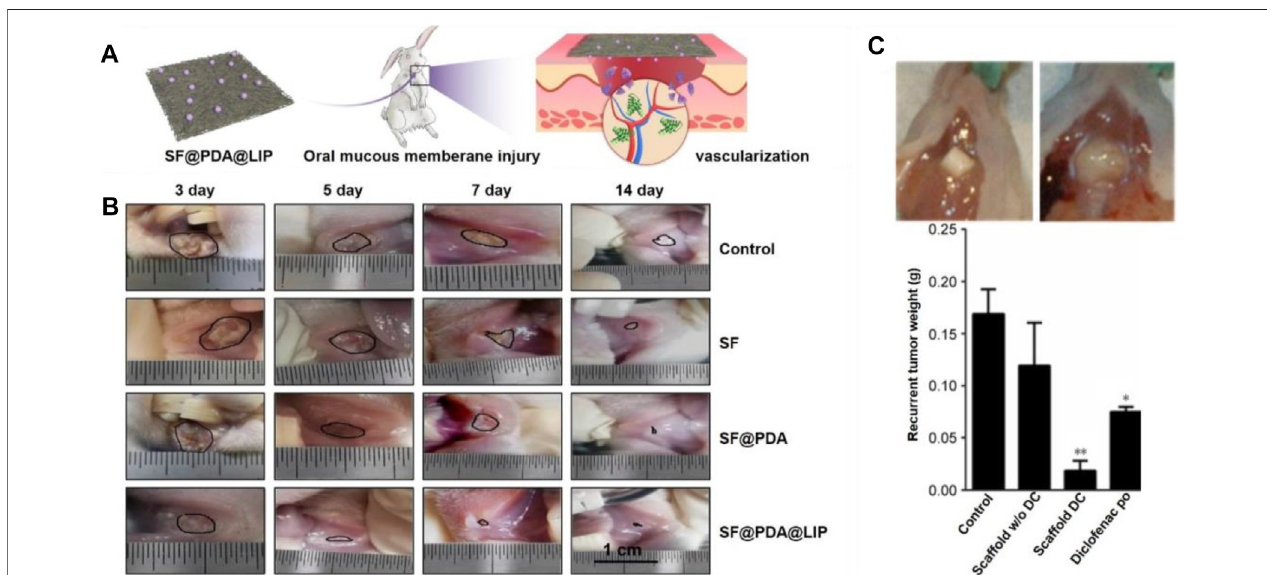
FIGURE9|(A) Silk fi broin fi bersdepositedwithleptin-loadedNH 2 -LIPswereusedtocoveroralmucousmembraneinjurytopromoteangiogenesis.Reproducedwithpermission (Qianetal.,2020).Copyright2020,CreativeCommonsAttribution. (B) Photographsshowingthehealingofinjuriesasmarkedbyblacklines.Reproducedwithpermission(Qianetal., 2020).Copyright2020,CreativeCommonsAttribution. (C) Effectofthelocalreleaseofdiclofenaconrecurrenttumorweight.Representativephotographsshowingtherecurrenttumor weightwaslowerwhentreatedbythediclofenac-loadedscaffoldat7 weekspostsurgery (topleft) .Thelargestrecurrenttumorwasobservedintheuntreatedgroup (topright) . Weightdistribution of recurrent tumorsin thedifferent experimental groups. Thelowestaverage weightwas observed in miceimplanted with diclofenac-releasingscaffolds. * p < 0.05, ** p < 0.01 (bottom). Reproduced with permission (Will et al., 2016). Copyright 2020, Dovepress.